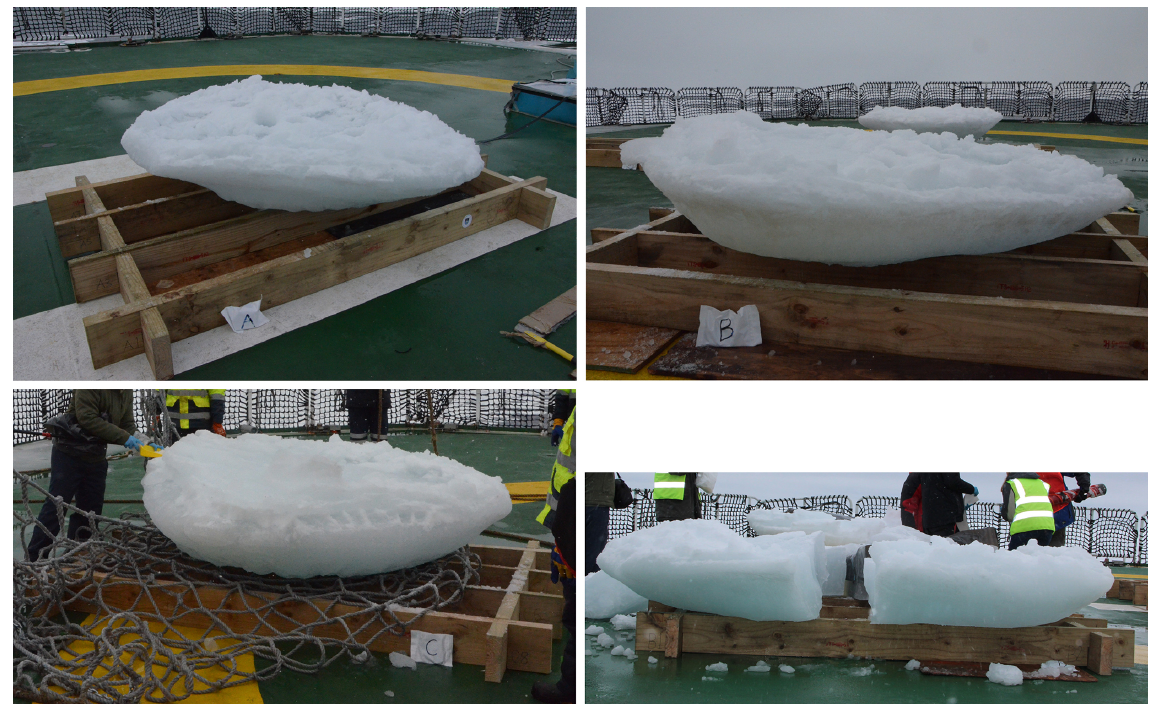
Figure 5. Pancake ice floes placed on wooden grids on the ship’s helideck: Pancake A (top left panel), Pancake B (top right panel), Pancake C (bottom left panel) and Pancake D (bottom right panel) shattered into six large pieces during removal from the